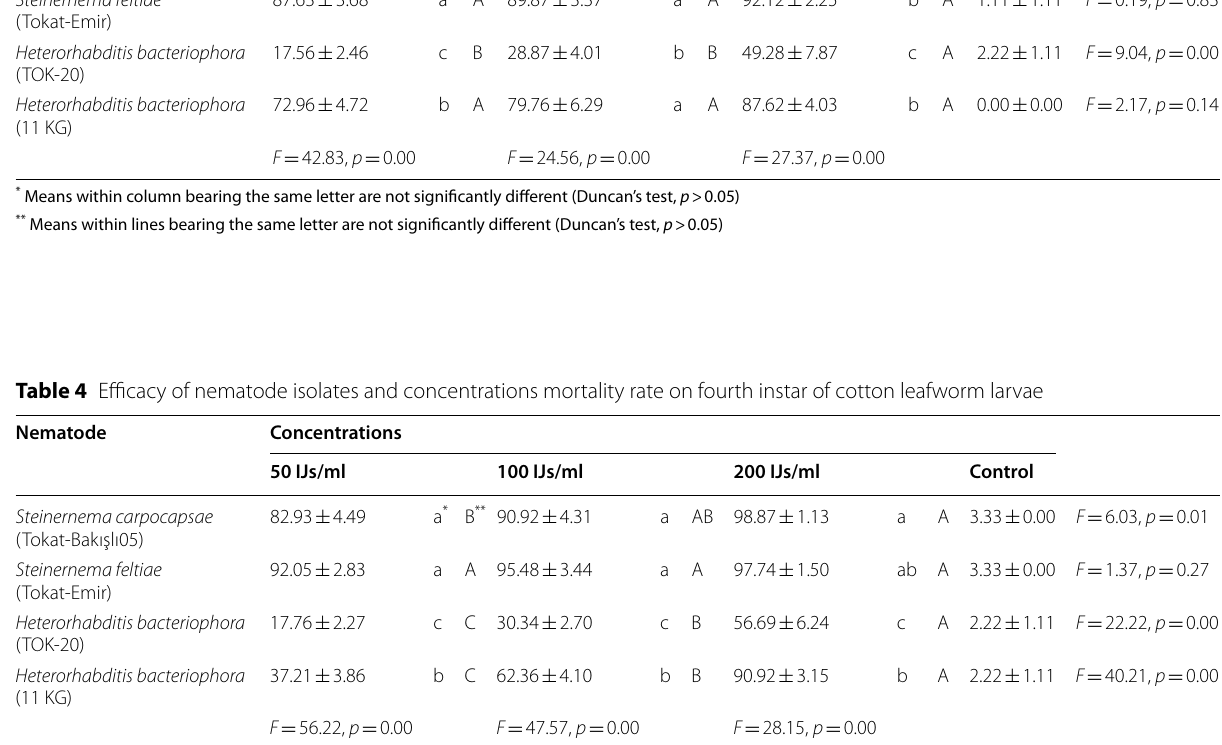
* Means within column bearing the same letter are not significantly different (Duncan’s test, p > 0.05) ** Means within lines bearing the same letter are not significantly different (Duncan’s test, p >